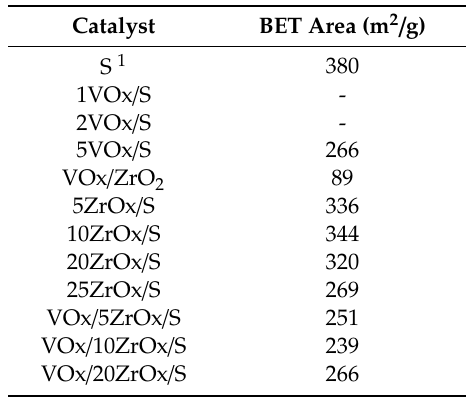
Table 1. BET surface area in synthesized